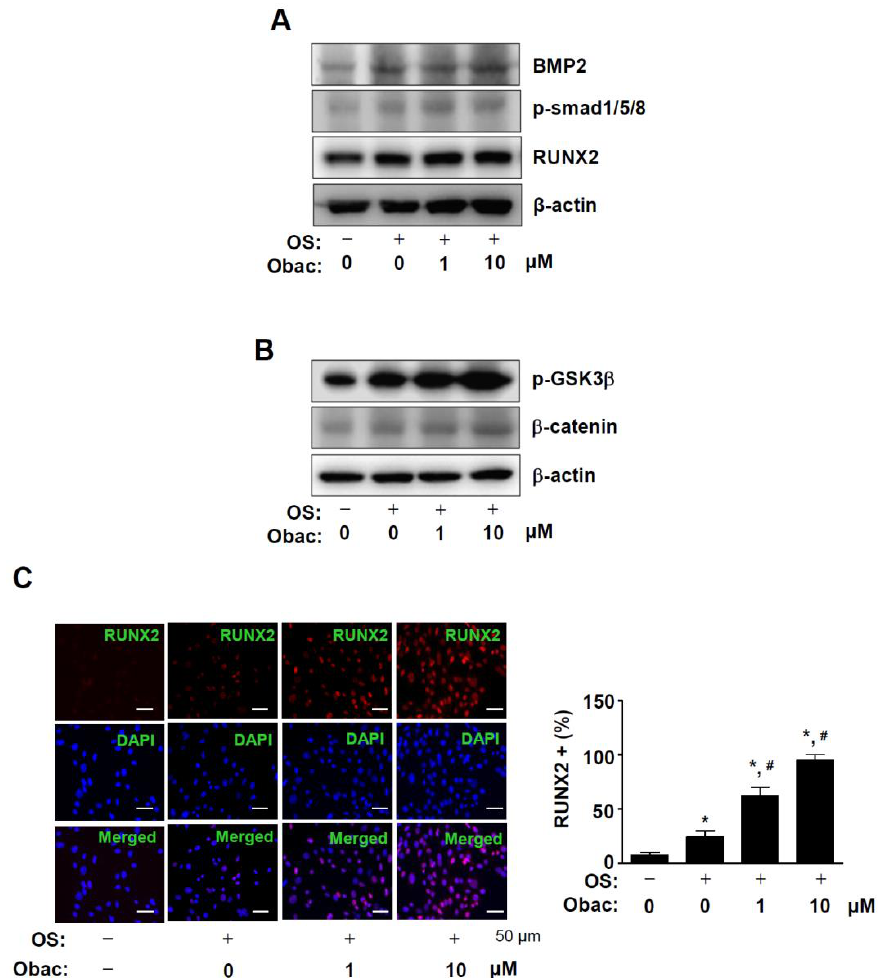
Figure 5. Effect of Obac on BMP2 and β -catenin signaling, and RUNX2 expression in osteoblast differentiation. ( A , B ) After 48 h, the equal amounts of lysates were assessed using antibodies against BMP2, phospho-Smad1/5/8 (p-Smad1/5/8), and RUNX2 ( A ), and phospho-GSK3 β (p-GSK3 β ) and β -catenin ( B ). β -actin was detected on the same sample to normalize the values obtained using Western blot analysis. ( C ) RUNX2 was immunostained with rabbit anti-RUNX2 antibody, followed by Alexa-Fluor 568-conjugated secondary antibody (red). After the cells were counterstained with DAPI (blue), the slides were mounted and visualized by a fluorescence microscope. The third panel shows the merged images of the first and second panels. RUNX2+ cells (%) were expressed in a bar graph. Scale bar: 50 µ m. Data are representative of three independent experiments.